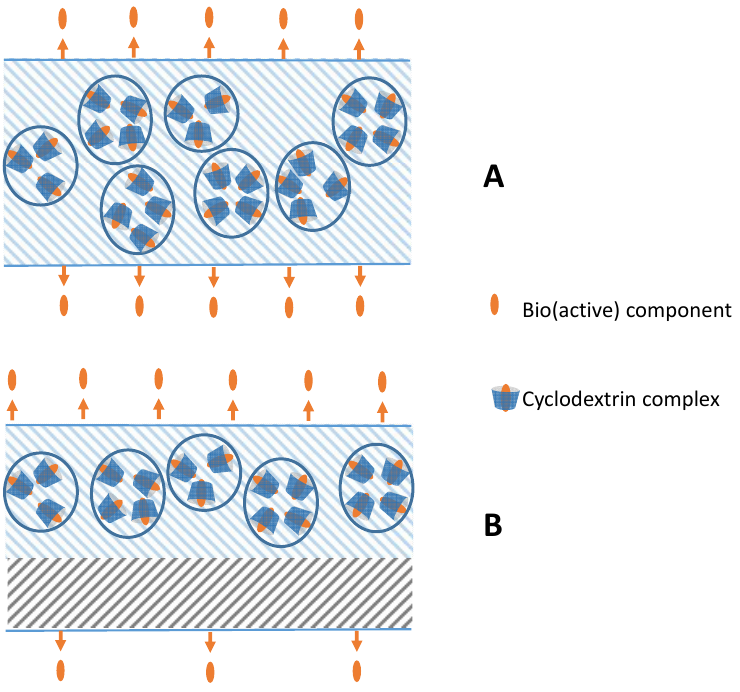
Figure 2. Cyclodextrin complexes are embedded into: ( A ) a polymer or ( B ) a coating layer on the polymer.